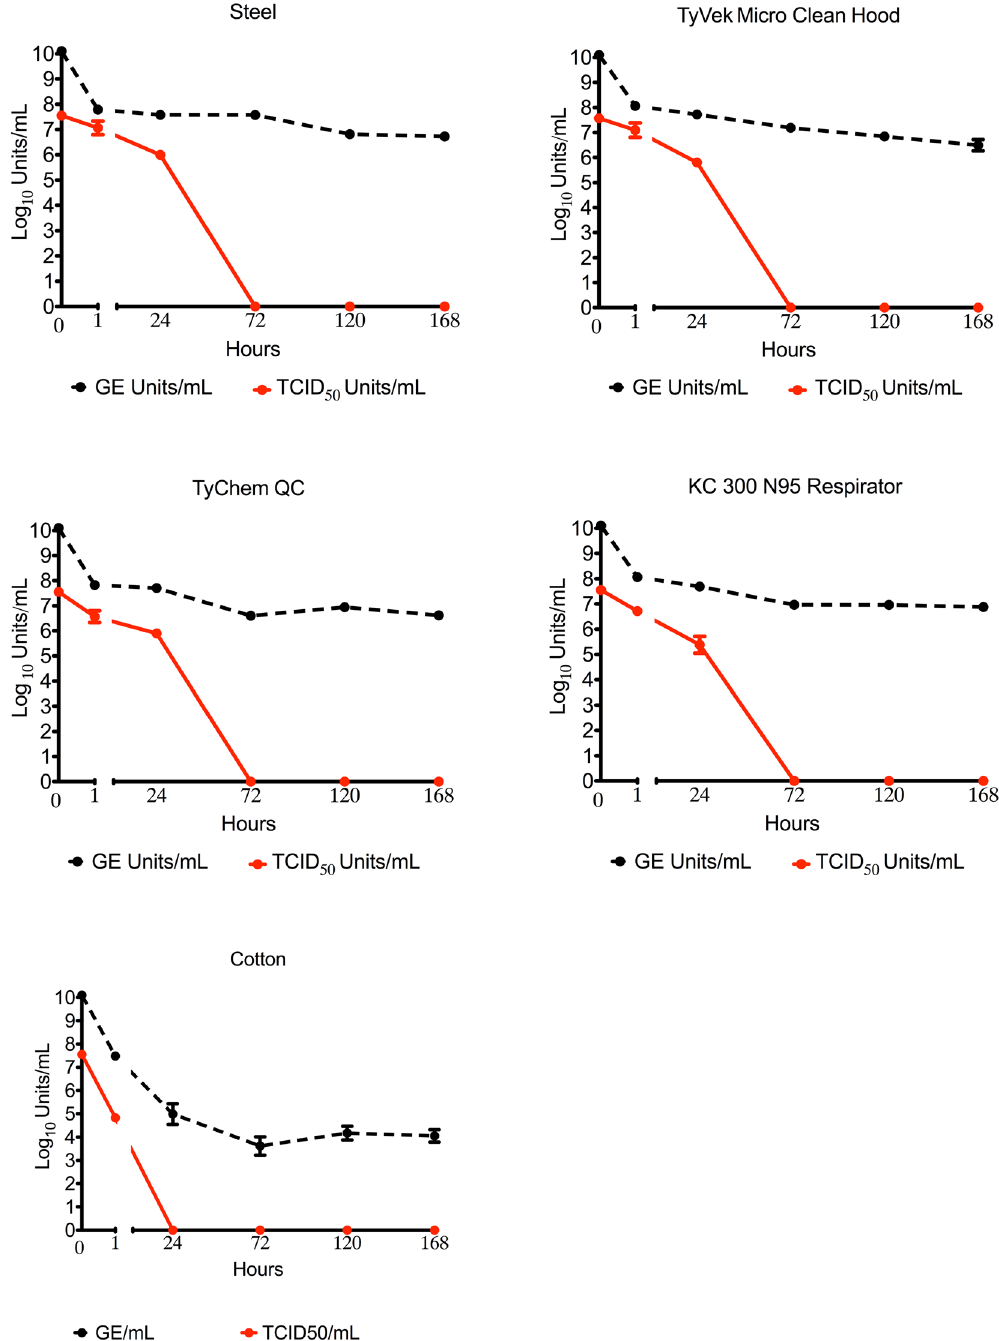
Figure 1. Persistence of infectious Ebola virus and viral RNA on PPE and ETU materials. Ebola virus was recovered from materials incubated in average West African climate conditions (27 °C and 80% RH) using a variation of the QCT-2 protocol published as ASTM E2197 – 11. The Environmental Persistence experiments were performed in three biological replicates, each consisting of three technical repetitions. Reported values are the average across all replicates (n = 9) error was calculated as standard error of the mean. Where: GE- genome equivalents and TCID 50 - tissue culture infectious dose